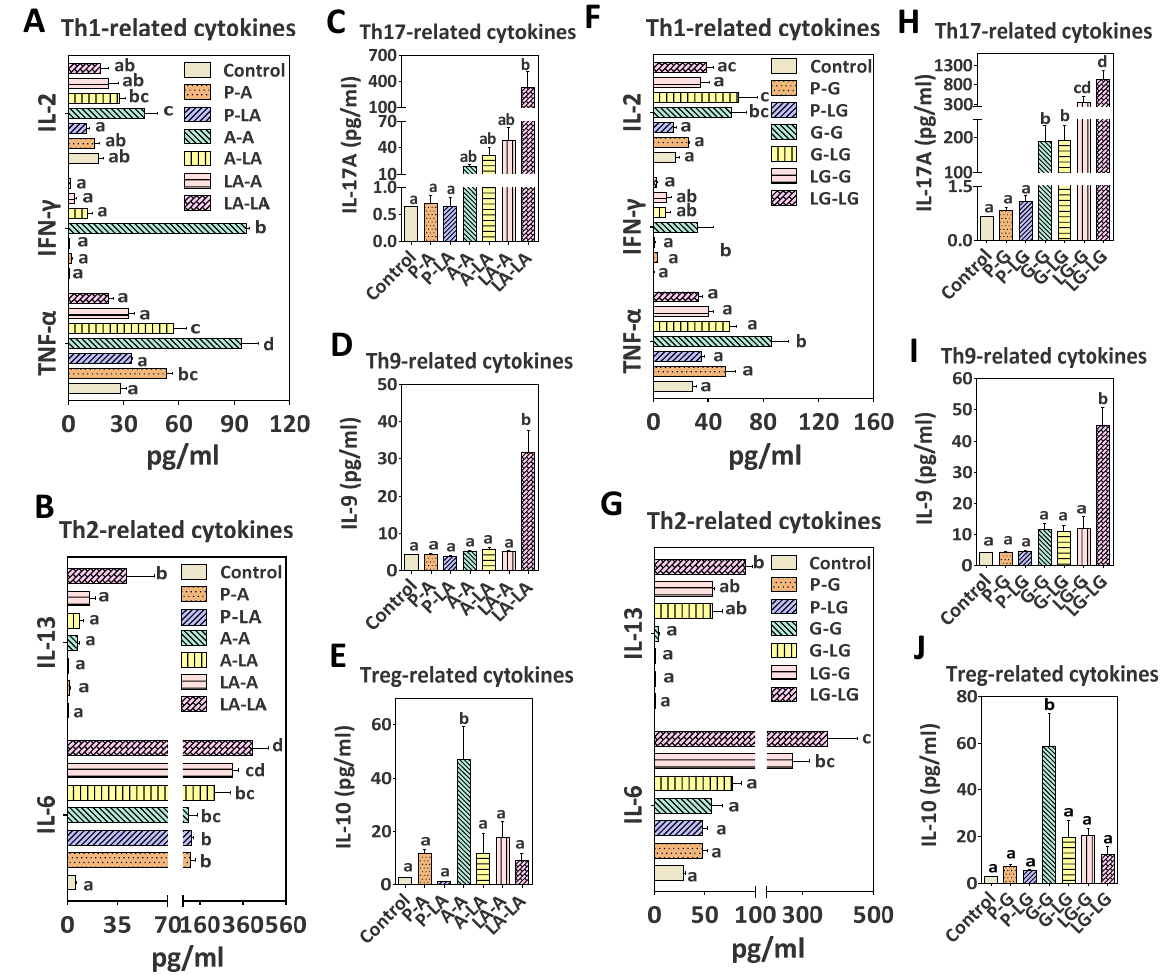
Figure 5. Production of Th1- ( A , F ), Th2- ( B , G ), Th17- ( C , H ), TH9- ( D , I ), and Treg-related ( E , J ) cy- tokines in spleen cell cultures. Individual splenocytes (4 × 10 6 ) of mice were stimulated with BLA